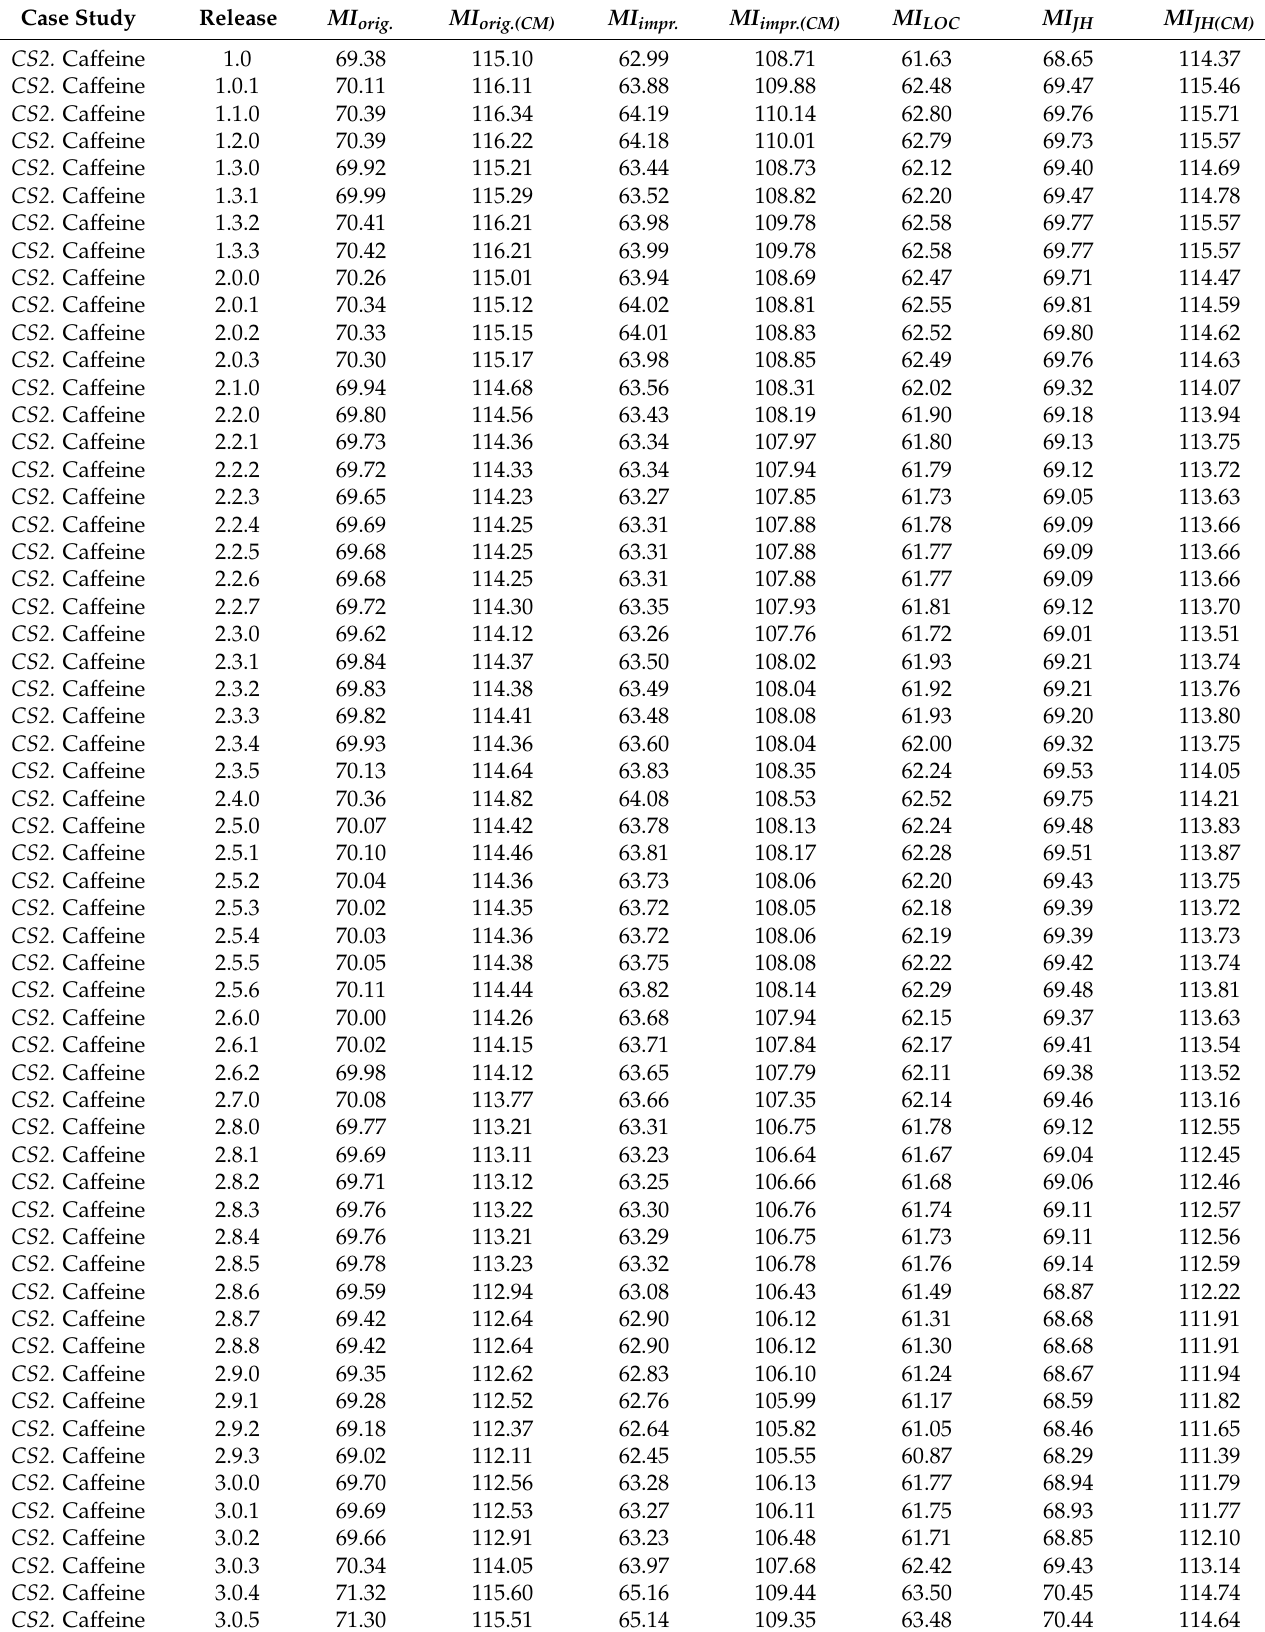
Table A3. Index variant values for CS2. Caffeine